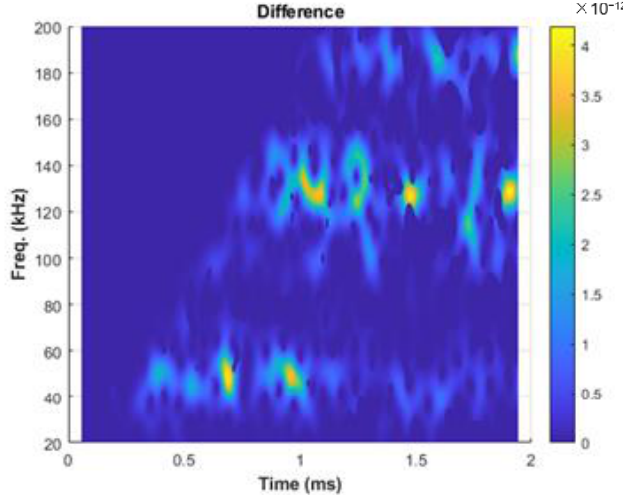
Figure 2. Example of the Short-Time Fourier Transform (STFT) of the difference signal, shown as a 2D contour map in the frequency – time domain. 2D contour map in the frequency–time